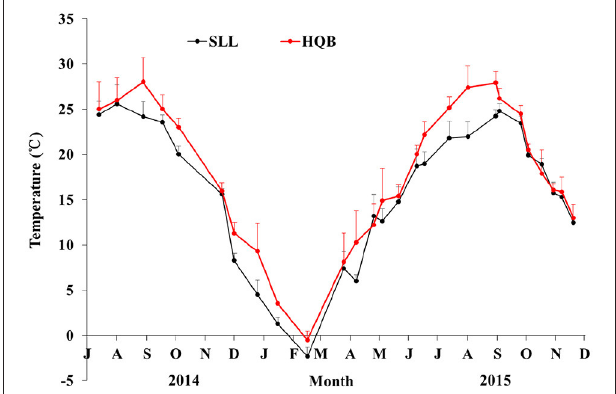
FIGURE 2 | Water temperatures of Swan Lake (SLL) and Huiquan Bay (HQB). Red line represents the temperature of HQB; black line represents water temperature of SLL. Values are means ± sd